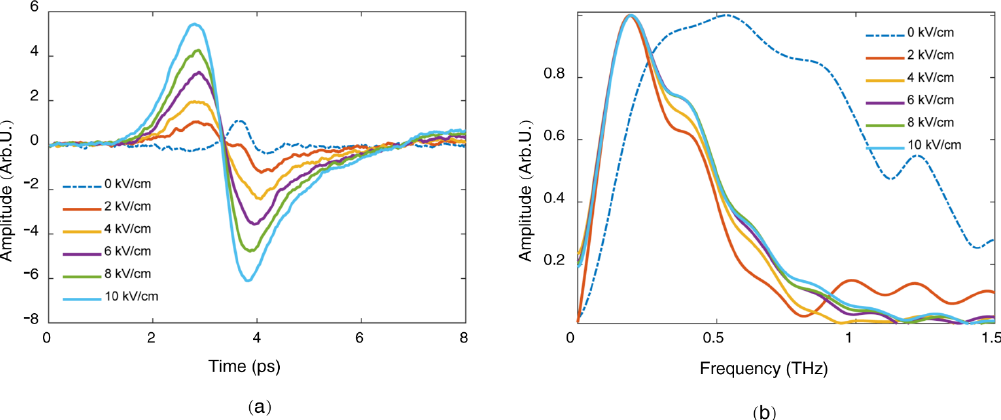
Figure 8. ( a ) Measured waveforms, and ( b ) corresponding spectra, of the radially polarized THz radiations when the external electric field changes from 0 to 10 kV/cm. With this longitudinally dc-biased filament, we could also slightly manipulate the peak frequency of the radially polarized THz radiation, except for its amplitude. In a long